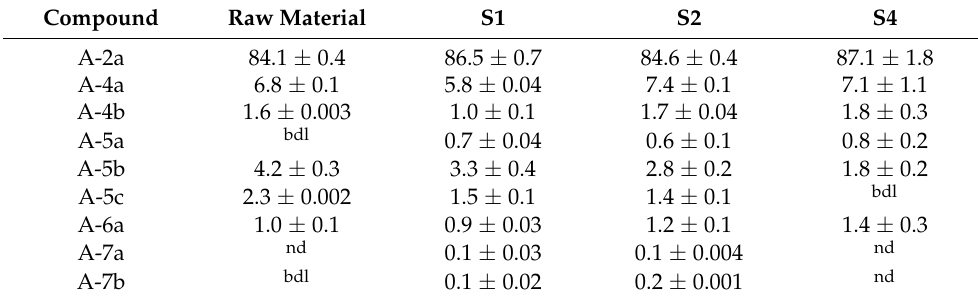
Table 4. Composition (mol%) of liberated arabinan oligosaccharides after incubation of insoluble dietary fiber (IDF) of enzymatically treated apple pomace (raw and extruded) with endo-arabinanase (mean value ± range/2, n = 2). S1: only transport elements, S2: two reverse elements, S4: two reverse elements and a kneading block, bdl: below detection limit, nd: not detected. Compound Raw Material S1